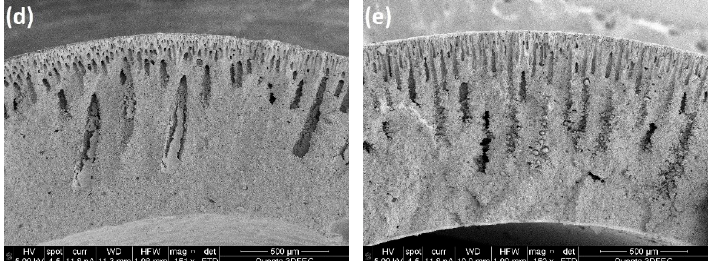
Figure 15. SEM images of MgO-CGO porous supports fabricated from slurries with ( a ) 0 wt%, ( b ) 7 wt%, ( c ) 13 wt%, ( d ) 20 wt% and ( e ) 27 wt% ethanol concentrations.